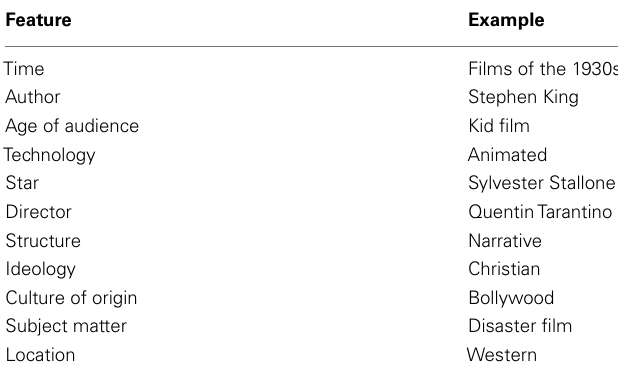
Table 1 | Genre features adapted from Chandler